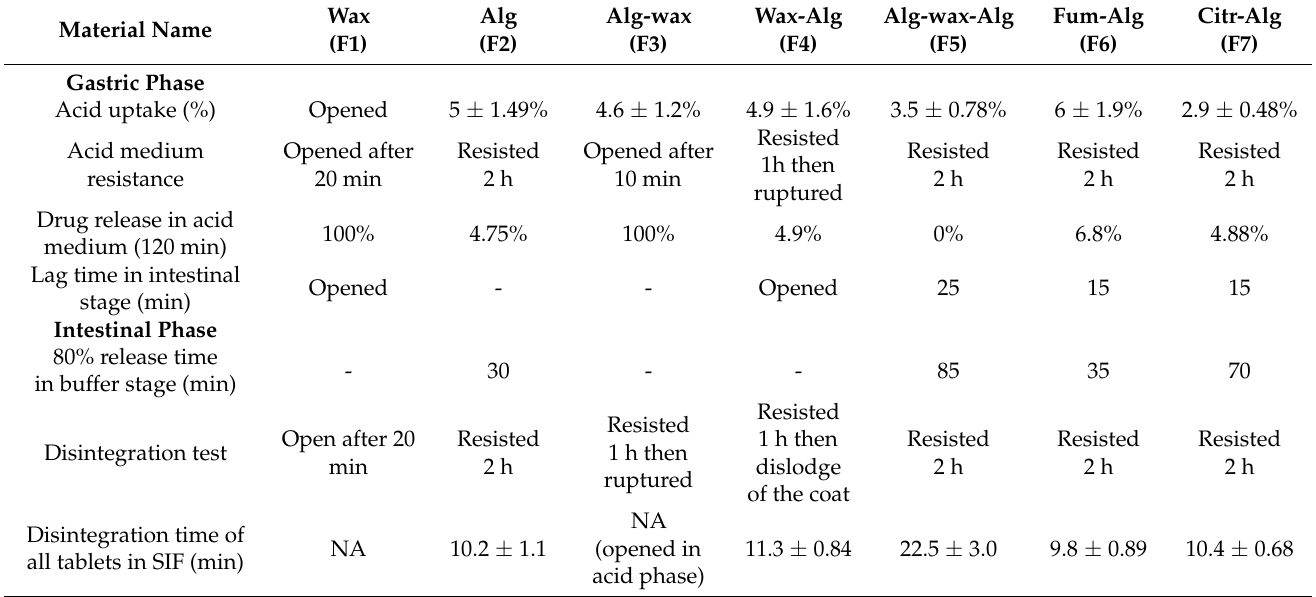
Figure 4. DSC thermographs of ( a ) single components of coating system, physical mixture, and casted film (F2); ( b ) organic acids and their casted film. Table 2. A summary of water uptake, acid resistance, and release characteristics of single-layer wax (F1), alginate-based (F2), and multi-layer (F3–F7)